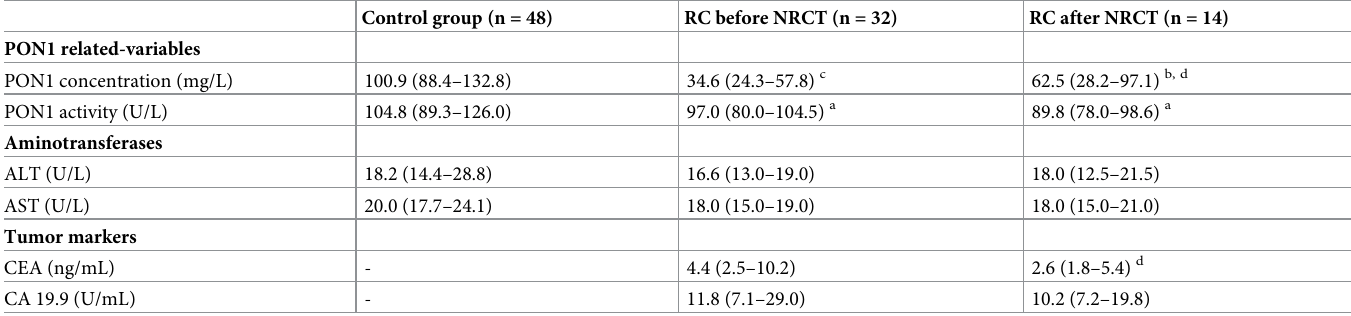
Table 3. Selected biochemical variables in the control group and Rectal Cancer (RC) patients, pre- and post- Neoadjuvant Radiochemotherapy